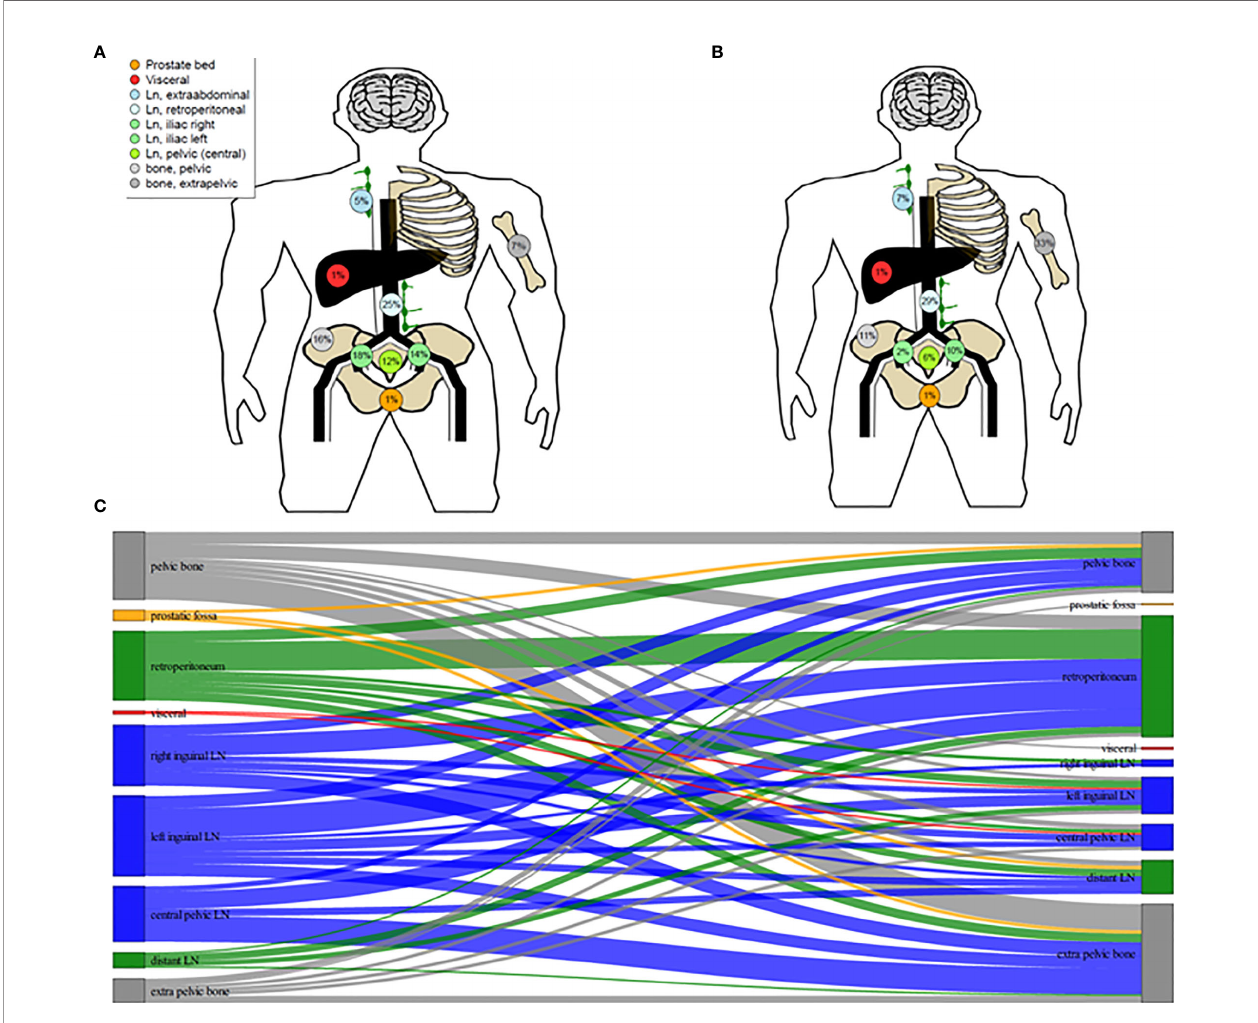
FIGURE 1 | Schematic illustration of 68 Ga-PSMA ligand PET/CT distribution of metastases of oligoprogressive prostate cancer under androgen deprivation therapy prior to radiotherapy (RT) (A) and distrubution of metastases at further progression after PSMA-guided RT (B) . Migration of Metastases (C)